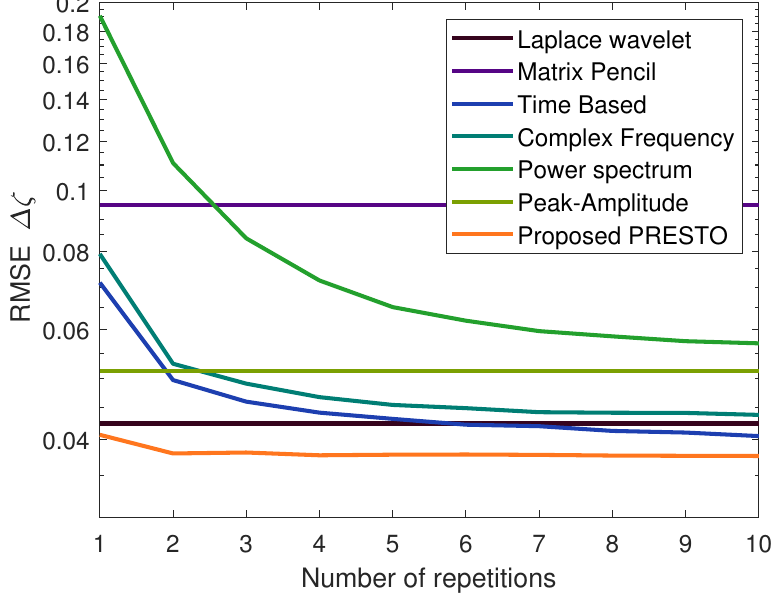
Figure 10. Root mean square error (RMSE) in the estimation of the damping factor ( ζ ) of two simulated underdamped modes. SNR 5 dB. Logarithmic